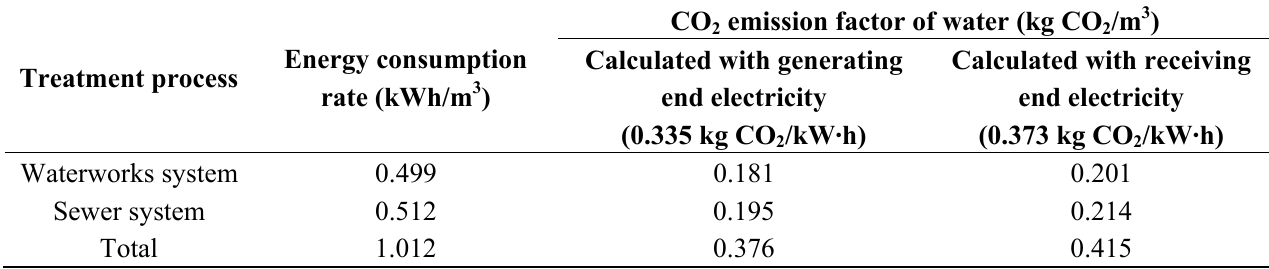
emission factor of water in Japan (FY 2008, kg CO 2